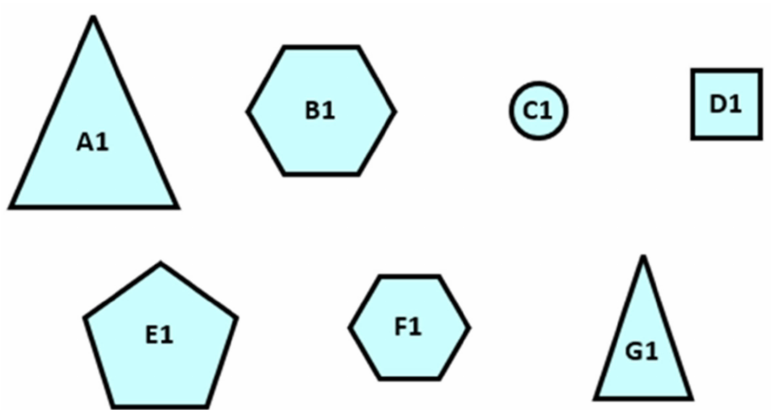
Figure 3. The first set of